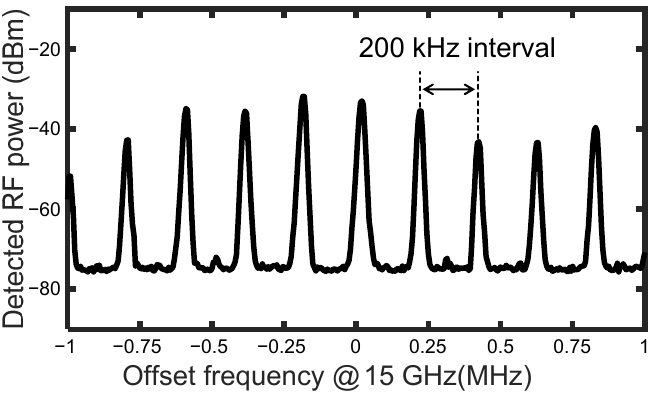
Figure 3. OEO signal spectrum exhibiting high power of spurious modes.